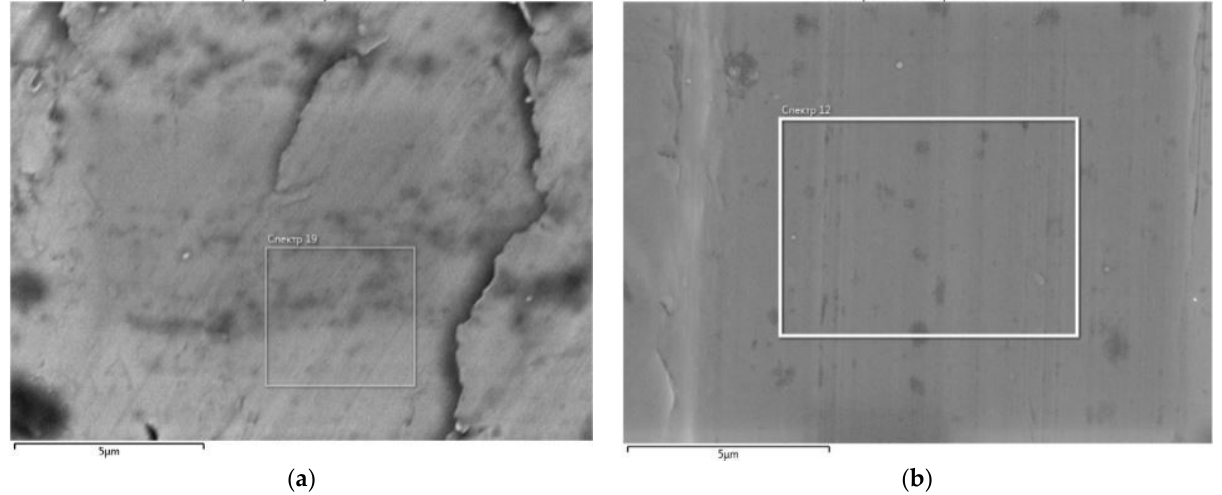
Figure 2. SEM image of the surface steel ( a ) before laser treatment and ( b ) after laser treatment (before connection with chemical reagent).